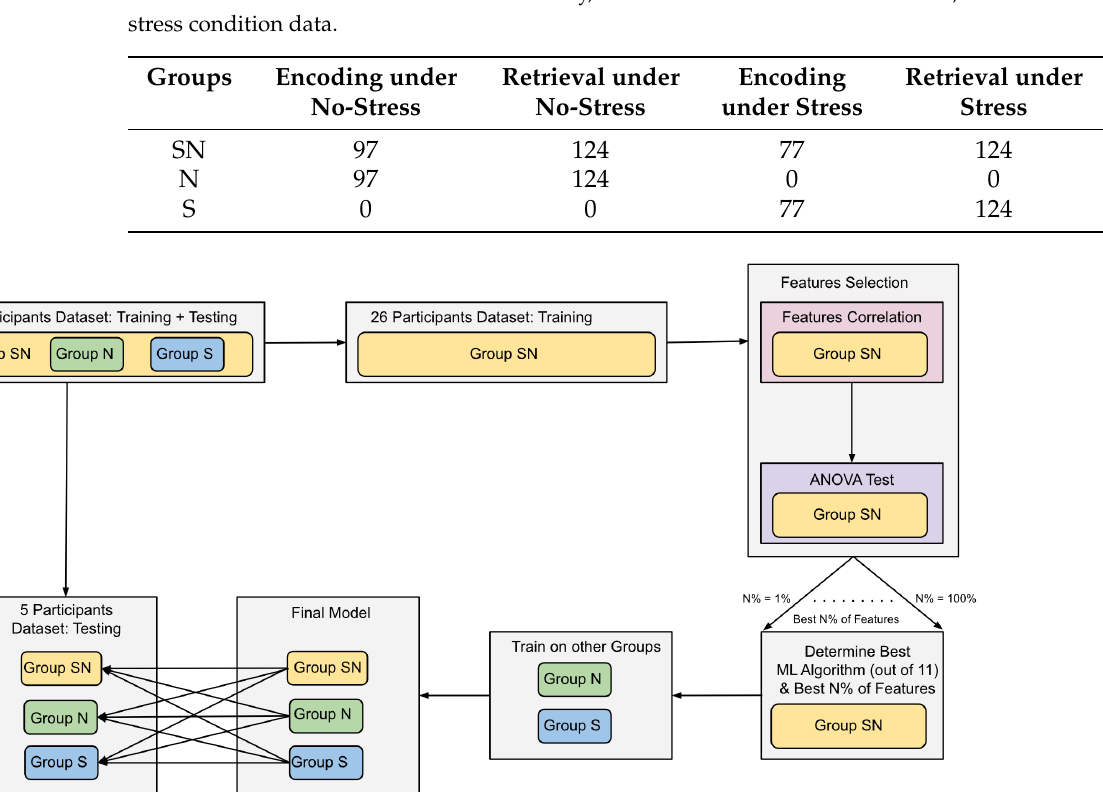
Figure 3. ML workflow diagram. The diagram illustrates the division of the dataset into training and testing. The training data from the Group SN is used to find the best combination of an ML algorithm and N% of the best features to classify encoding and retrieval of information. Once they are determined, they are used to train two models on Group N and Group S data. The final three models are then tested on the testing datasets, and the F1-Score and accuracy of detecting memory encoding and retrieval are